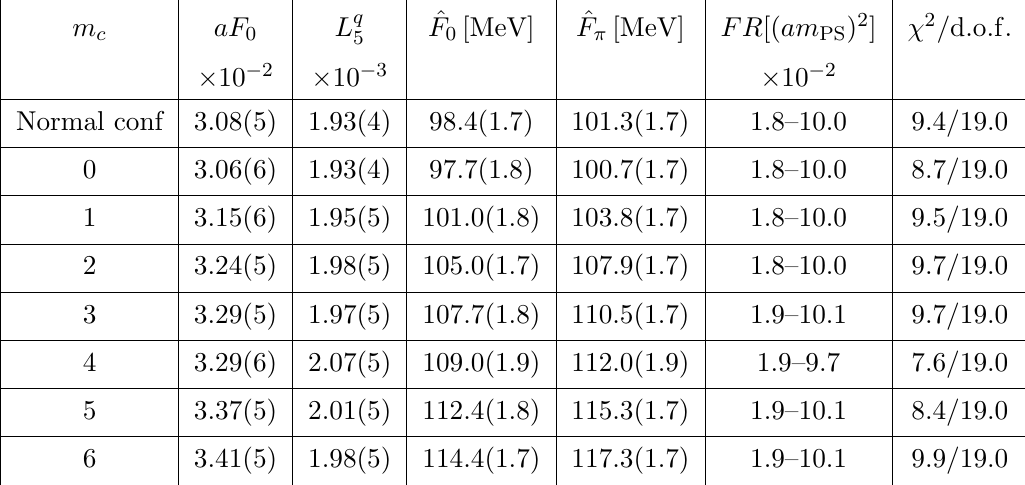
Table 12 . The (cid:12)tting results of aF 0 and L q constants ^ F 0 and ^ F (cid:25)